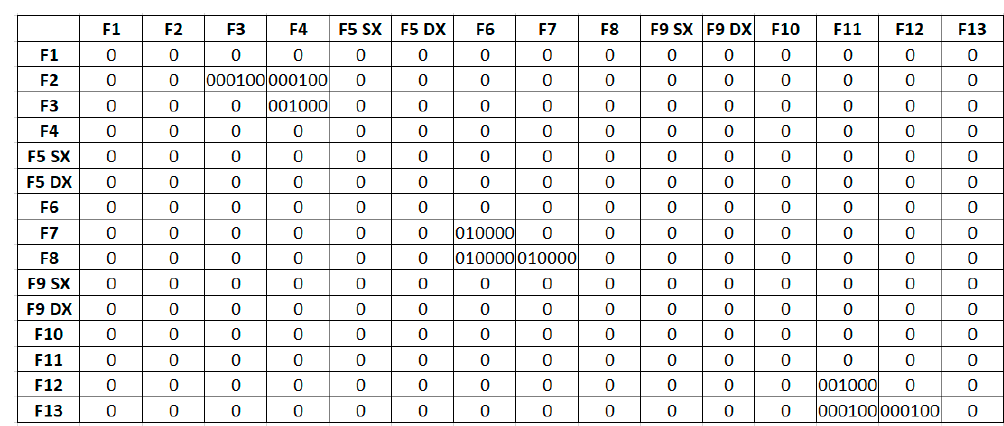
Figure 17. CCM (components components matrix).